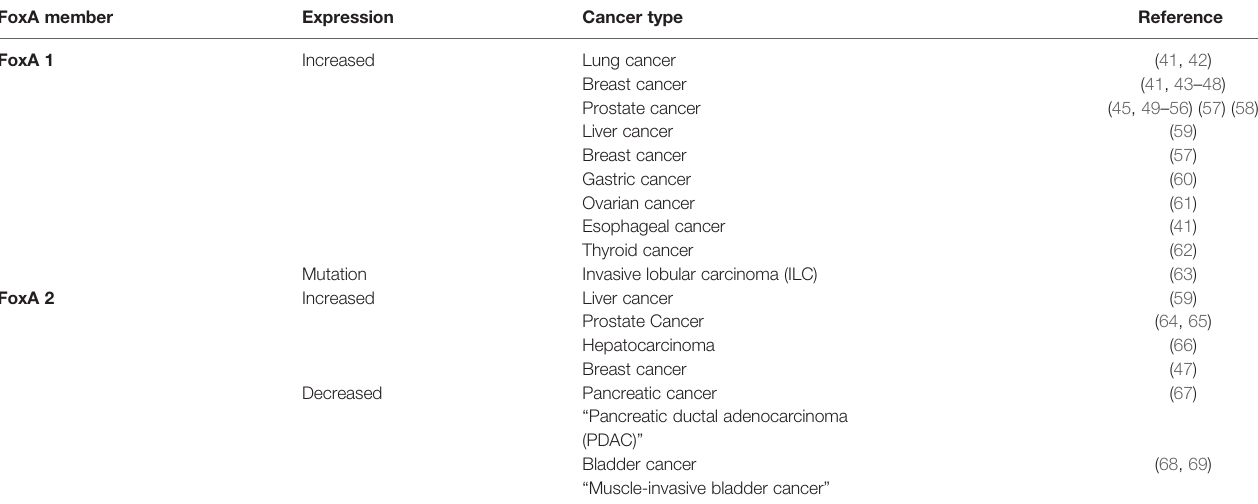
TABLE 1 | The association between each member of FoxA family and different cancers. FoxA